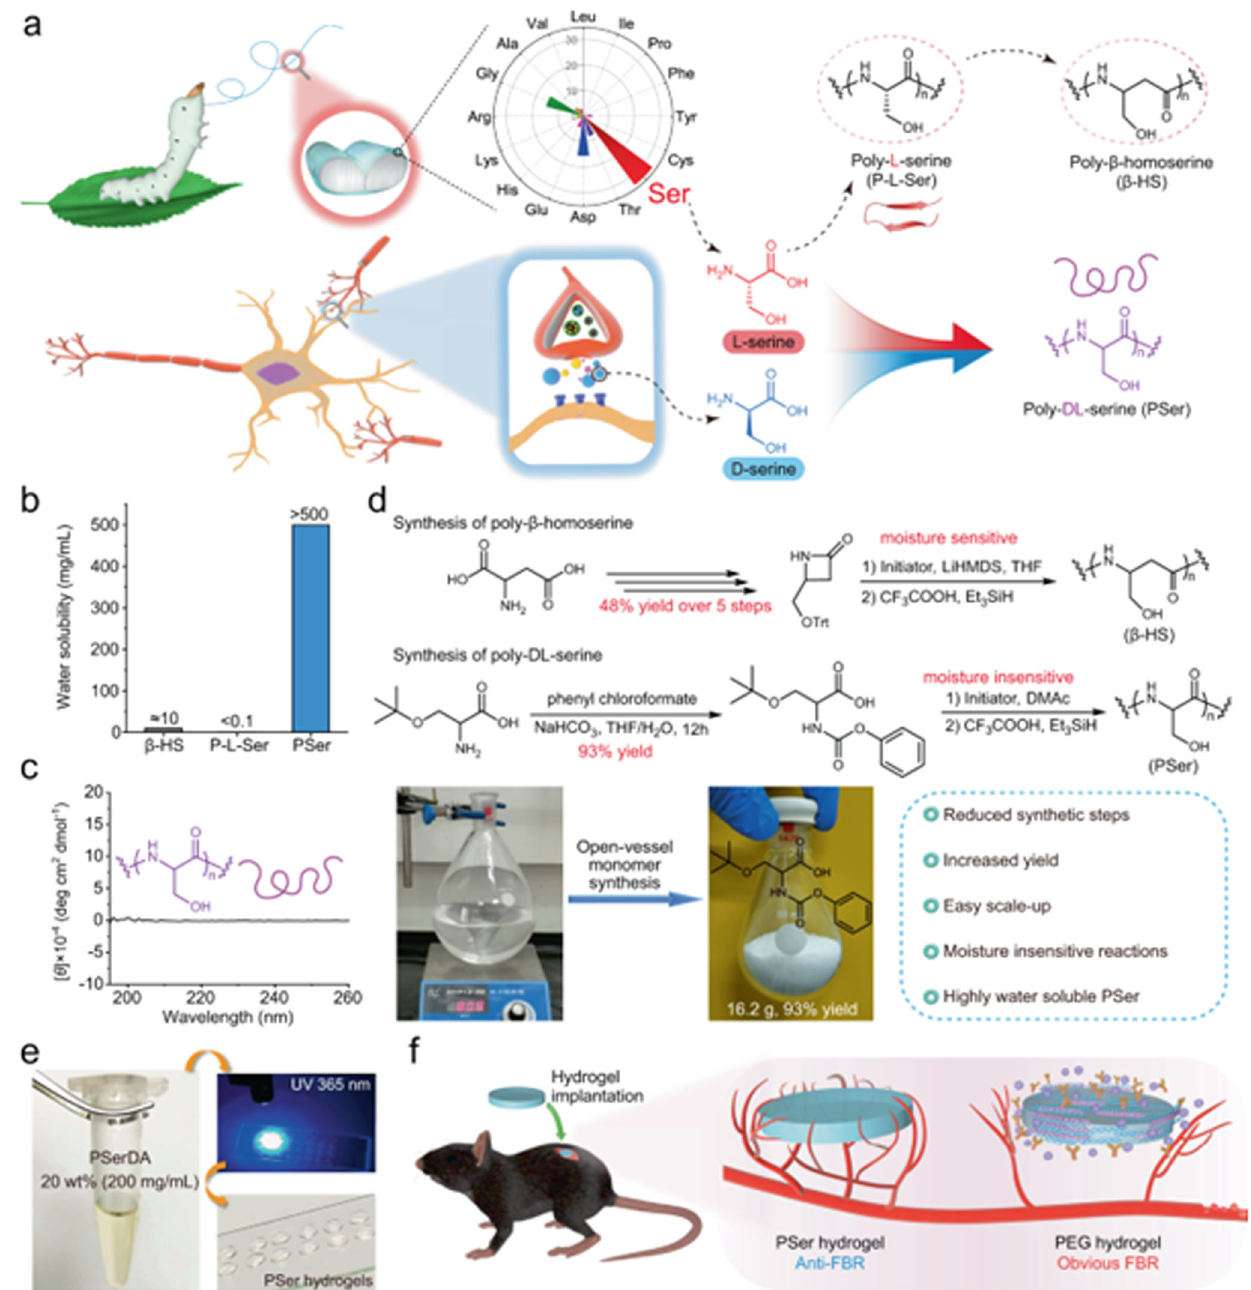
Fig. 2 Examples of ‘ synthesis to application ’ of hydrogels. a Design of poly- DL -serine (PSer) from L -serine and D -serine. The high L -serine content in silk sericin and the high level of D -serine in the human body as an important neurotransmitter altogether inspired the design of anti-FBR material PSer. b Water solubility of poly- β -homoserine ( β -HS) (about 10 mg/mL), poly- L -serine (P- L -Ser) (<0.1 mg/mL due to its β -sheet folding) and PSer (>500 mg/mL). c Circular dichroism spectrum of PSer. d Synthesis of β -HS and PSer. LiHMDS Lithium hexamethyldisilazide, DMAc dimethylacetamide. e Photographs of poly- DL -serine diacrylamide (PSerDA) that was well dissolved at a concentration of 20 wt% and was used to prepare PSer hydrogels by photo-crosslinking in the presence of 0.1% photoinitiator (Irgacure 2959). f PSer hydrogels and PEG hydrogels implanted subcutaneously into C57/BL6 mice induced low FBR and obvious FBR respectively (Figure reproduced from Zhang et al. Nat. Commun. 12 , 5327 (2021),